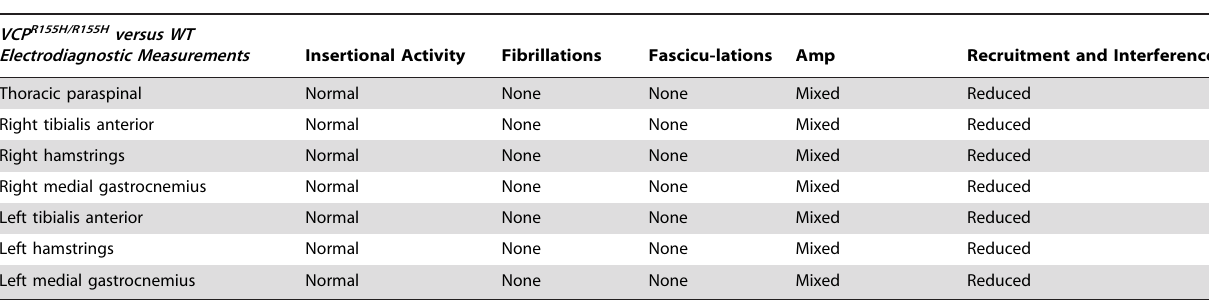
Table 1. EMG measurements of myopathic changes in VCP R155H/R155H versus WT littermates.